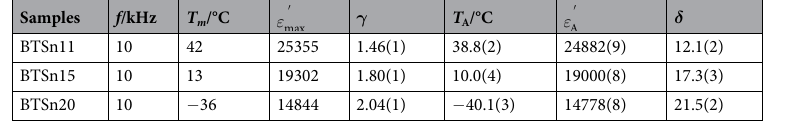
Table 1. The parameters obtained from fitting by Eqs (1) and